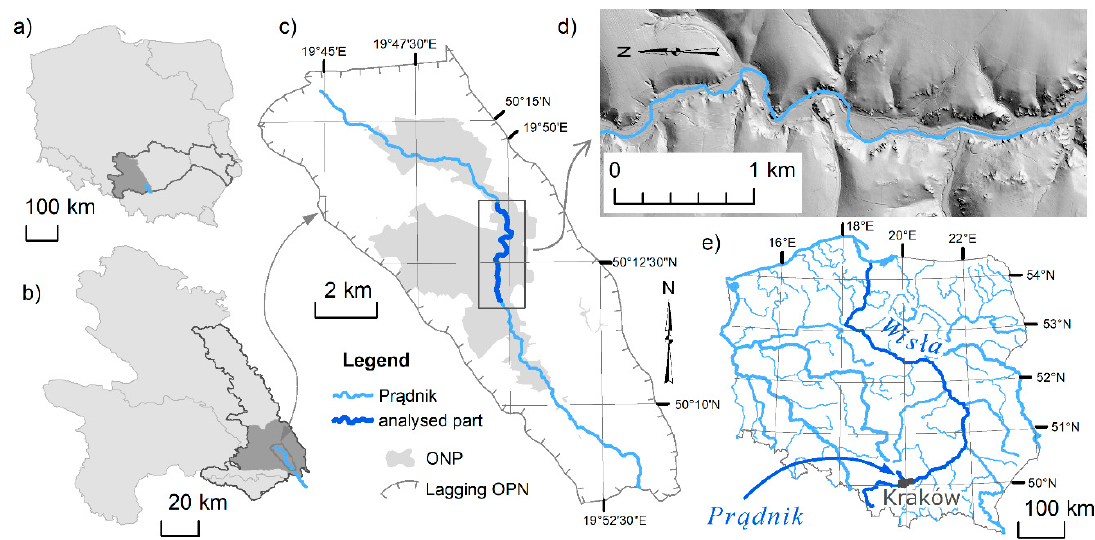
Figure 1. Location of the area of study ( a ) in a physico-geographical province (dark grey line) and sub-province (dark grey area), ( b ) in a physico-geographical macro-region (dark grey line) and mesoregion (dark grey area), ( c ) Ojców National Park buffer zone, ( d ) hillshaded DTM, ( e ) Pr ą dnik and the Vistula (Wis ł a)—a river longer than 100 km in Poland.